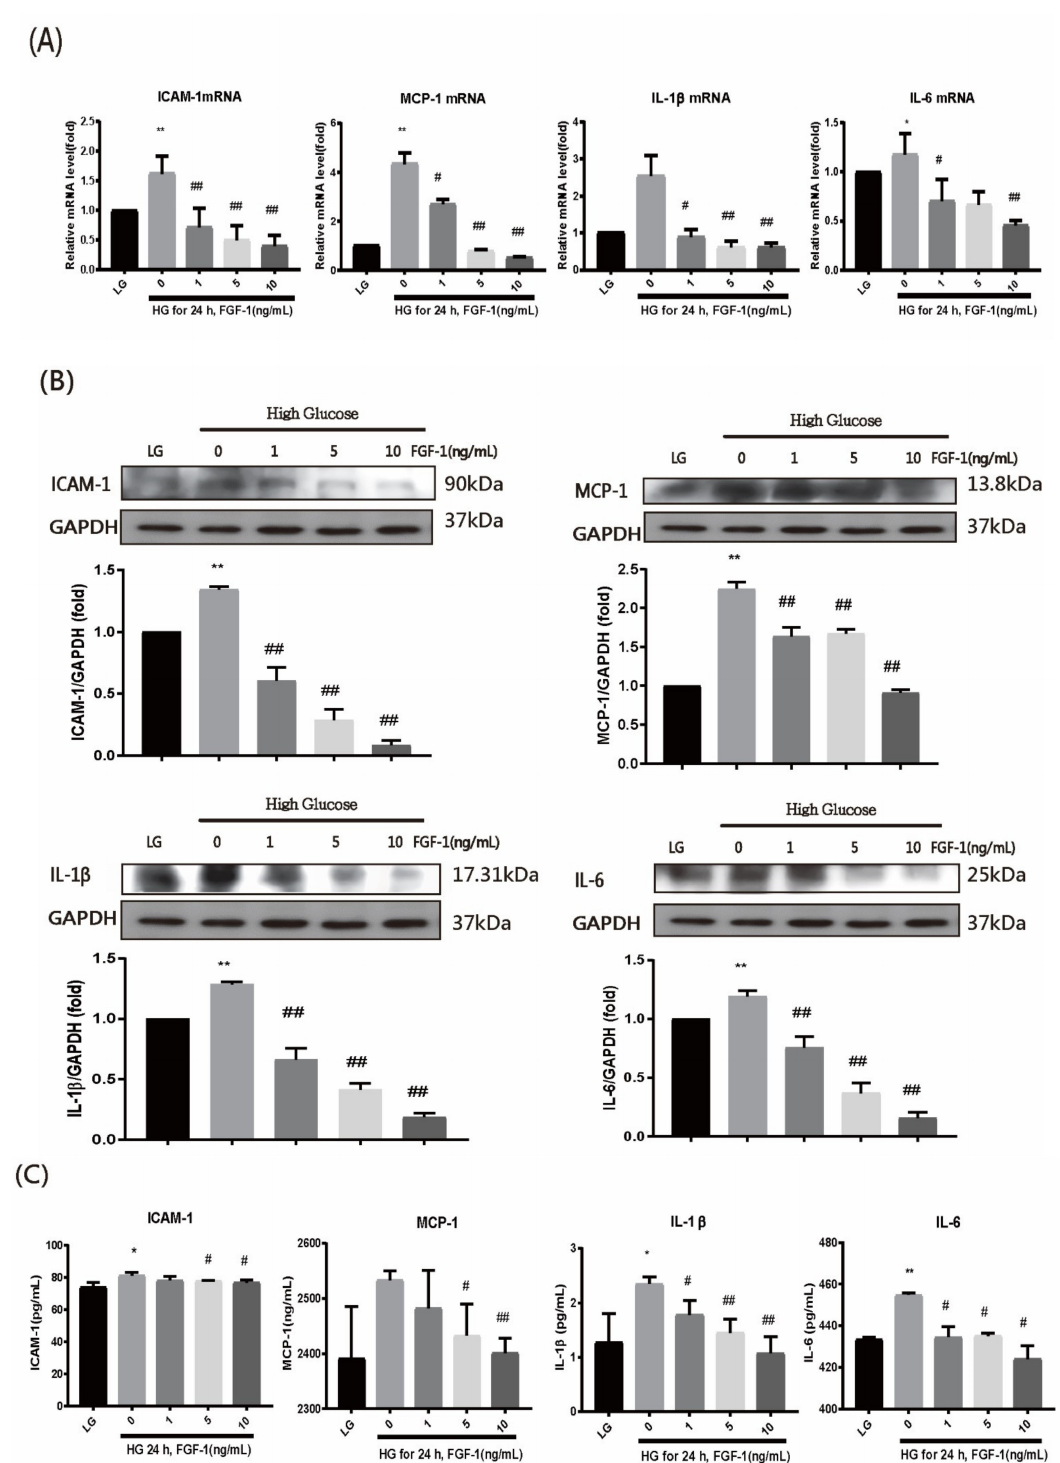
Figure 5. FGF-1 treatment alleviates cell inflammation in ARPE-19 cells incubated in high-glucose medium. After pretreat- ment with different concentrations of FGF-1 (1, 5, and 10 ng/mL) for 2 h, ARPE-19 cells were incubated in a high-glucose (25 mM) medium for 24 h. ( A ) Expression levels of inflammatory mediators (ICAM-1, MCP-1, IL-1 β , and IL-6) were detected using RT-PCR. ( B ) Protein expression of inflammatory mediators was assessed using western blot analysis. ( C ) Protein expression of inflammatory mediators in cell culture medium was assessed using ELISA ( n = 5 in each group). * p < 0.05, ** p < 0.01 compared with control cells incubated in low-glucose medium; # p < 0.05, ## p < 0.01 compared with ARPE-19 cells incubated in high-glucose medium. LG, low glucose; HG, high glucose; FGF-1, fibroblast growth factor type 1; GAPDH, glyceraldehyde-3-phosphate